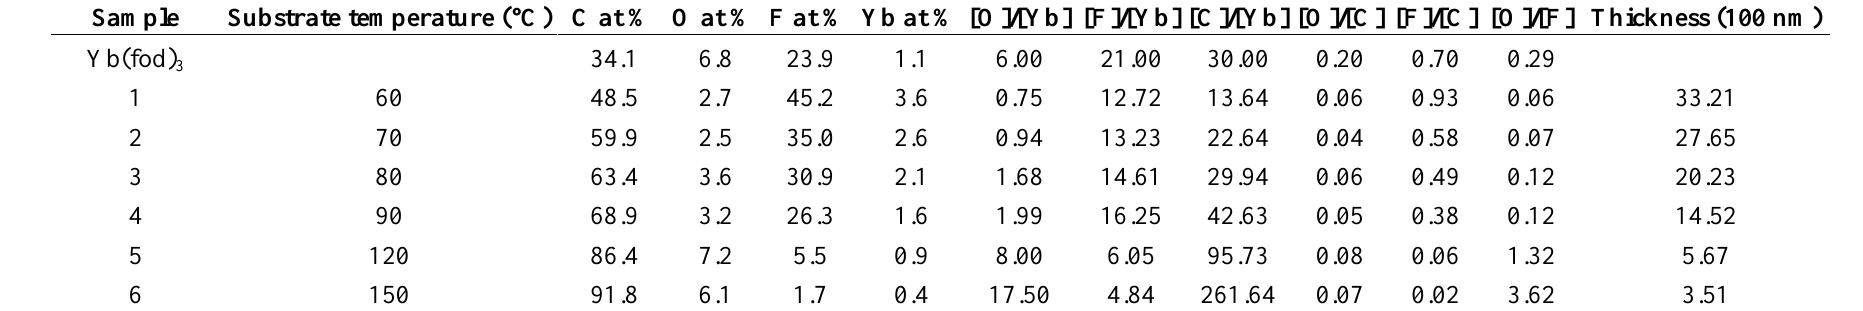
Table 1. Ratios of atomic concentrations and relative/absolute atomic concentrations of relevant elements in as-received stoichiometric Yb(fod) compound, and in six a-C:D:F(Yb) films deposited under varying conditions as determined from XPS measurements. 3